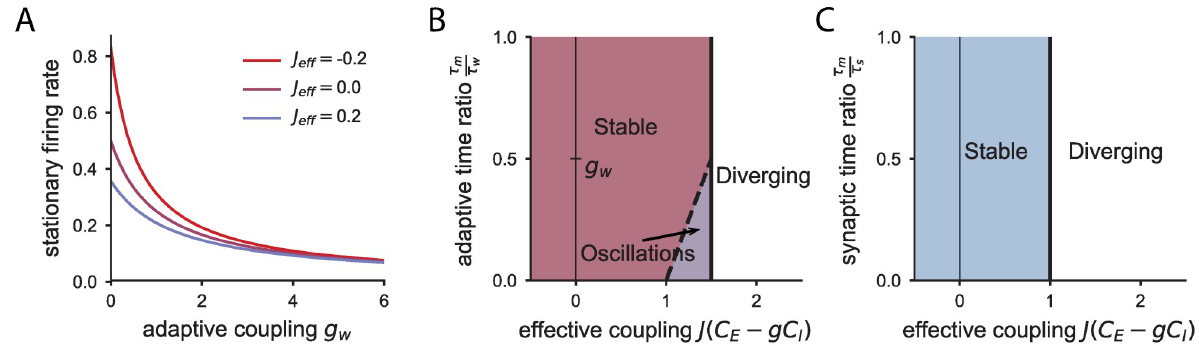
Fig 2. Equilibrium firing rate and phase diagrams of the population-averaged dynamics. A: Firing rate of the network with adaptation at the equilibrium ϕ ( x 0 ) for increasing adaptive couplings and three different values of the effective recurrent coupling J eff = J ( C E − gC I ). Stronger adaptation leads to lower firing rates at equilibrium. B: Phase diagram of the population-averaged activity for the network with adaptation. C: Phase diagram for the network with synaptic